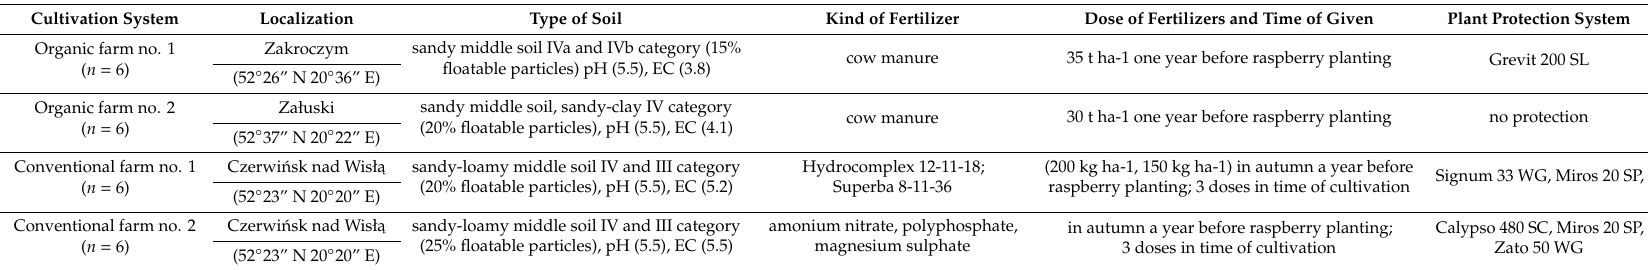
Table 1. Characterization of localization, fertilizers regime and plant protection used for organic and conventional raspberry cultivation in